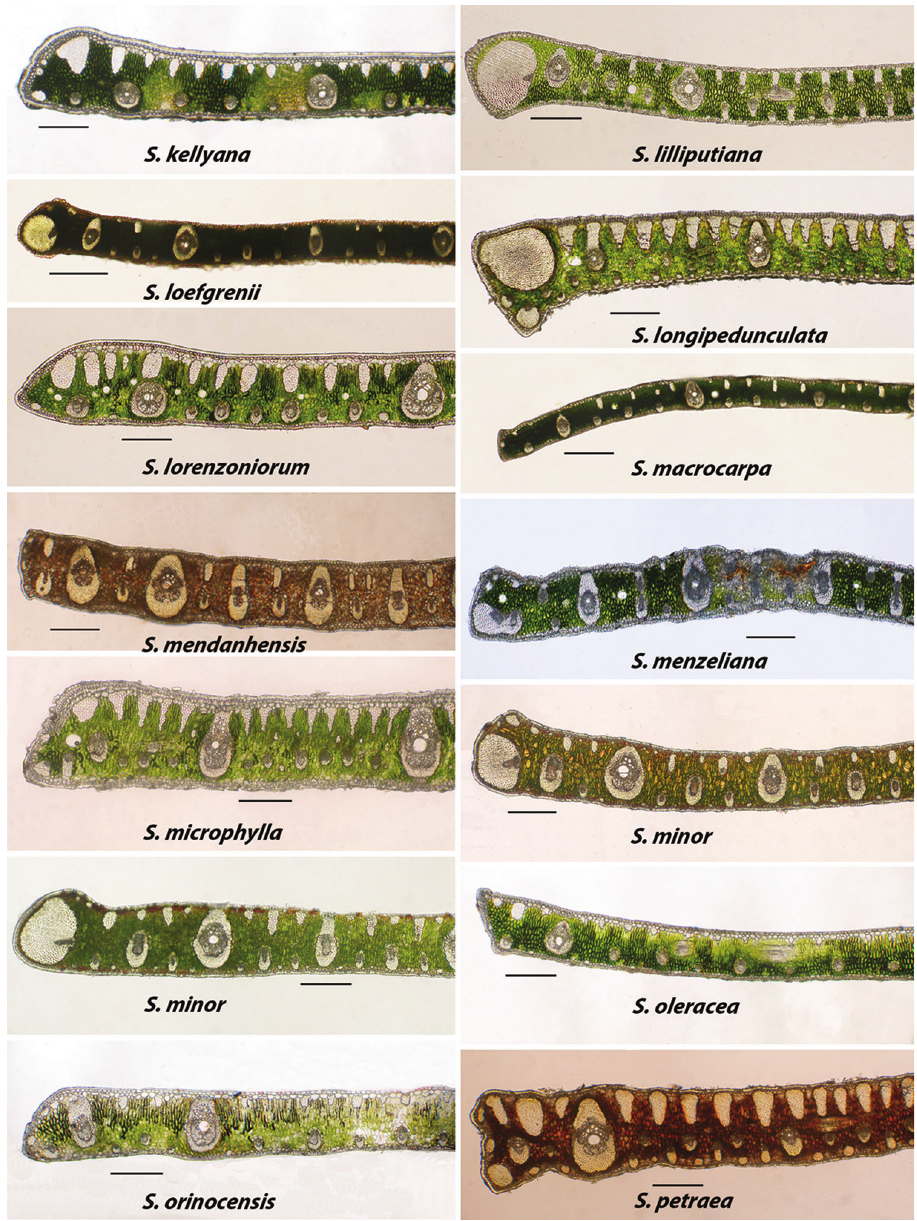
Figure 6. Alphabetically arranged marginal leaflet transections. Syagrus kellyana to S. petraea . Note vari- ation in S. minor . Bar scale = 0.25